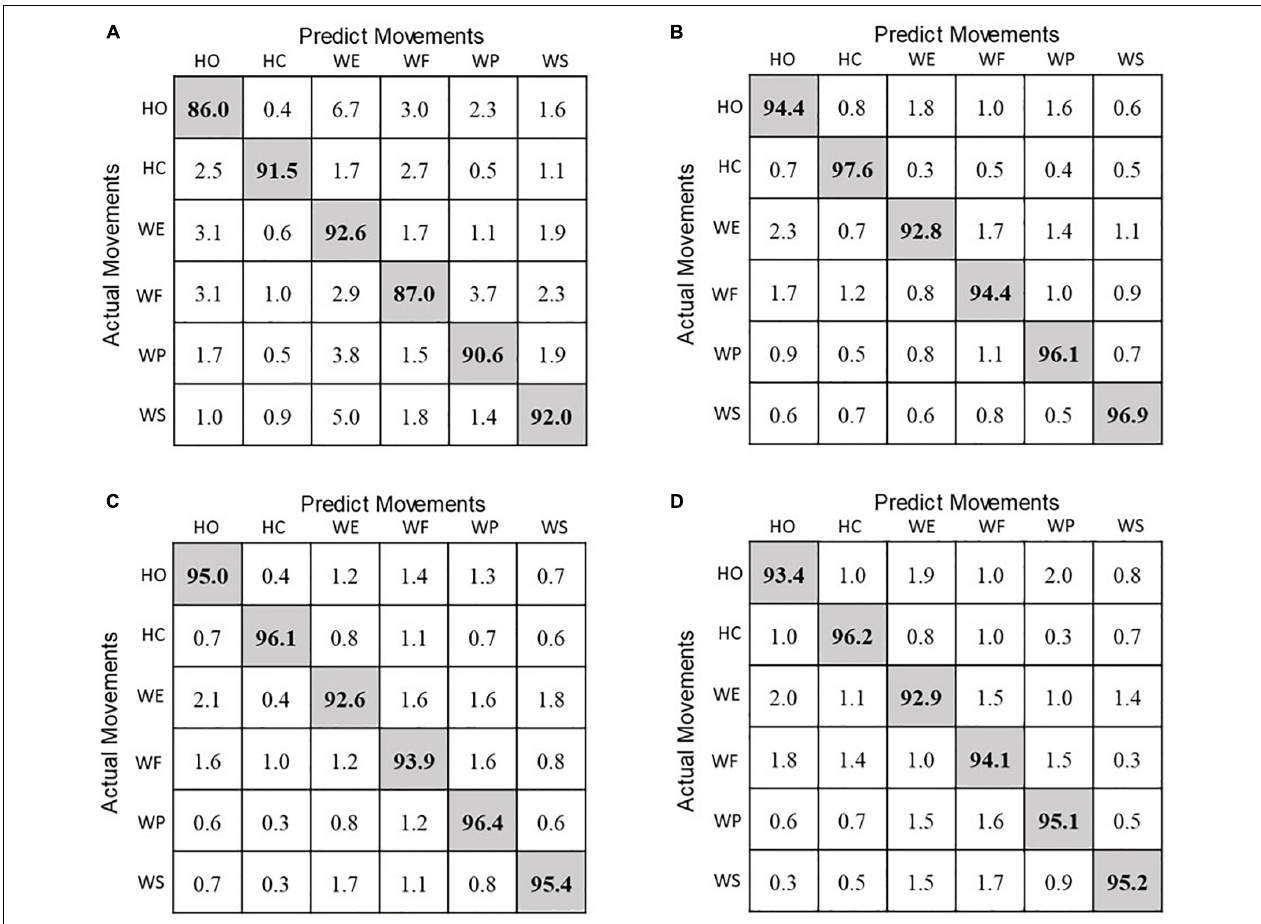
FIGURE 8 | Confusion matrix of classification accuracies (%) for (A) LDA, (B) KNN, (C) ANN, and (D) SVM